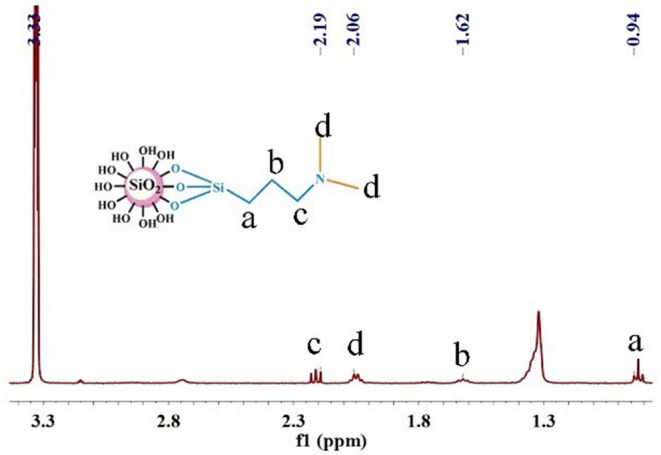
1H NMR spectra of responsive nano-SiO2, using CD3OD as a solvent.